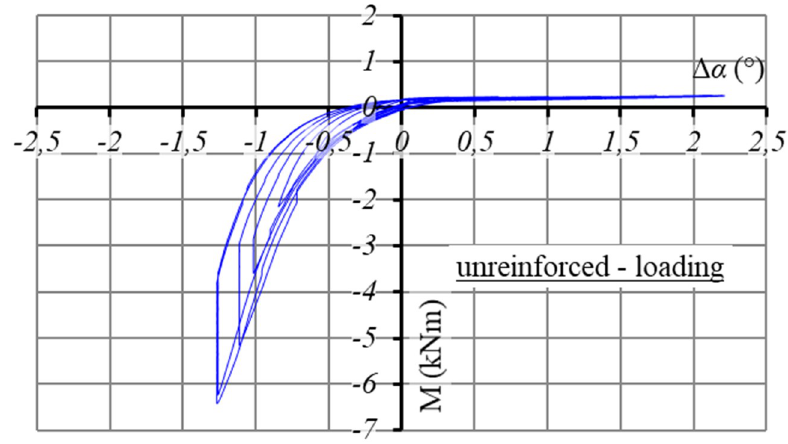
Figure 9. Hysteresis loops of a typical imperfect halved dovetail joint before retrofitting.